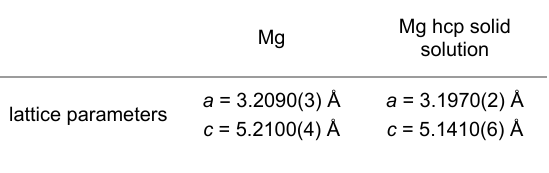
Table 1: Lattice parameters for Mg and Mg-type solid solution formed during the reaction of MgH 2 with Li.